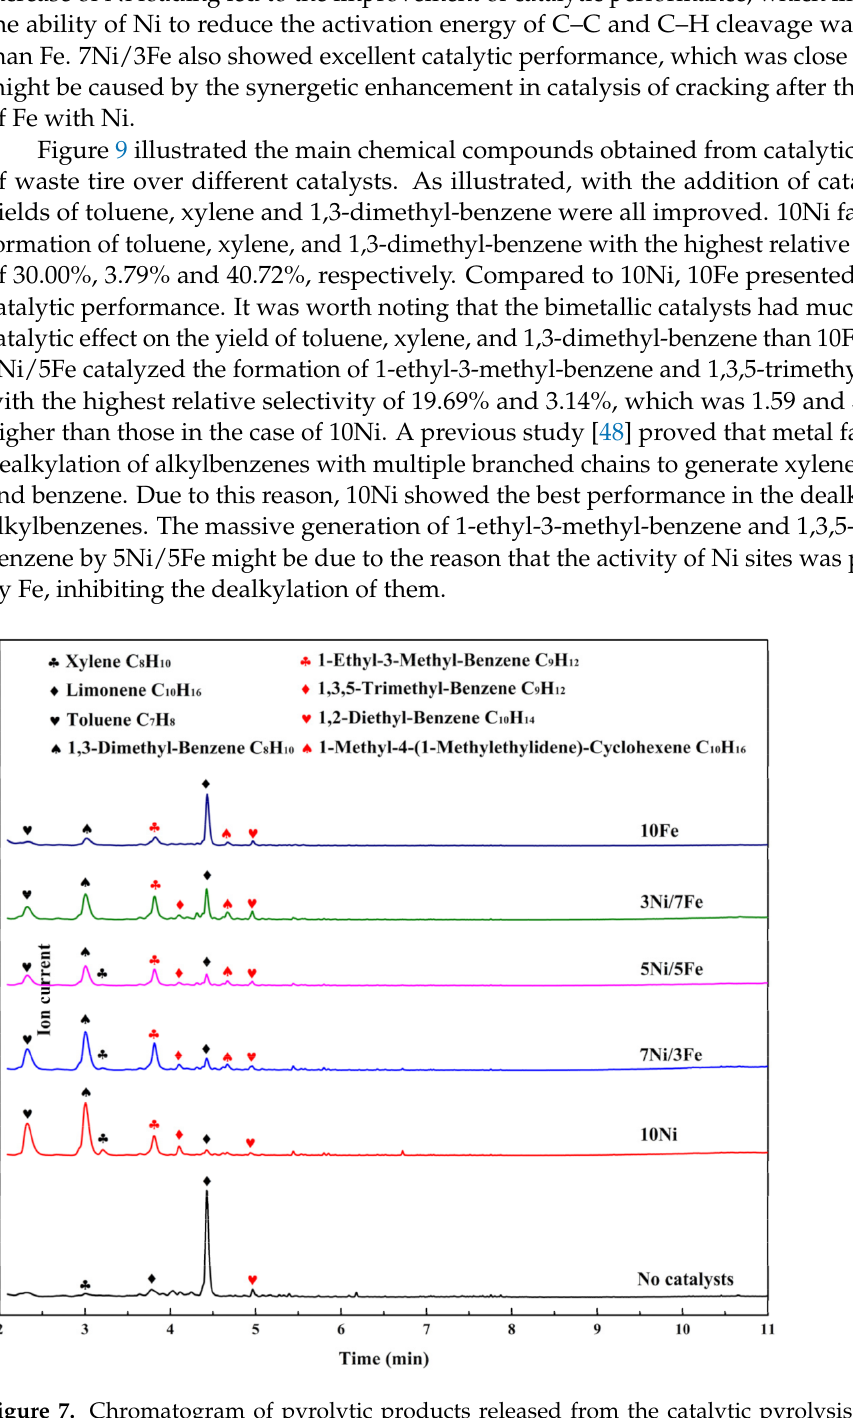
Figure 7. Chromatogram of pyrolytic products released from the catalytic pyrolysis process of waste